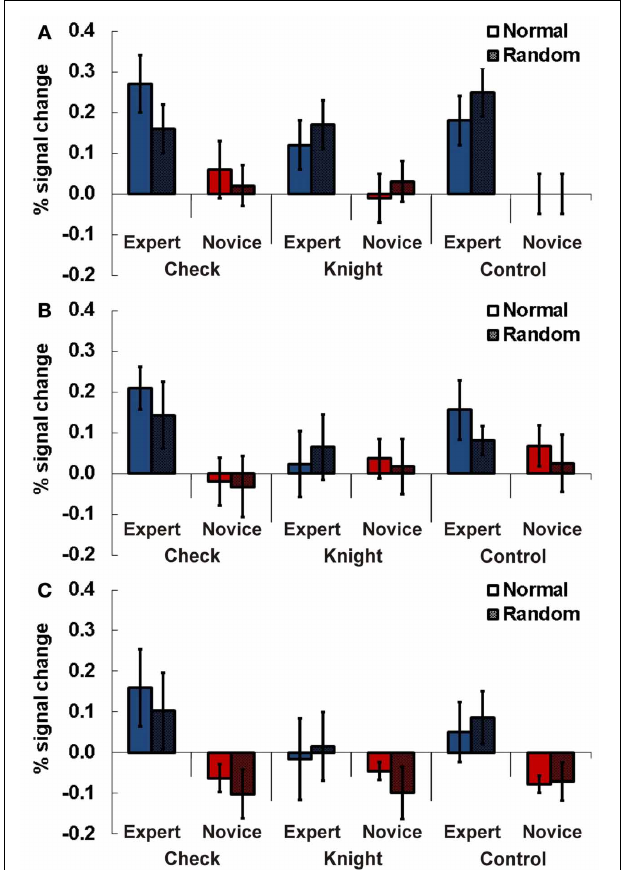
FIGURE 5 | Results Experiment 3. Percent signal change (PSC) for the three experimental conditions check (recognizing if the white king is in check), knight (recognizing if black/white knights are present), and control (recognizing if a black/white dot is presented) for experts and novices in normal (chess pieces arranged according to real chess matches) and random (chess pieces in randomized distribution) chess arrays. Results are presented for TPJ ROI right (A) , left anterior (B) , and left posterior TPJ (C) . Error bars indicate standard error of the mean.